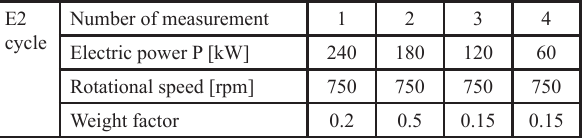
Table 2. E2 cycle engine adapter to the laboratory engine according to